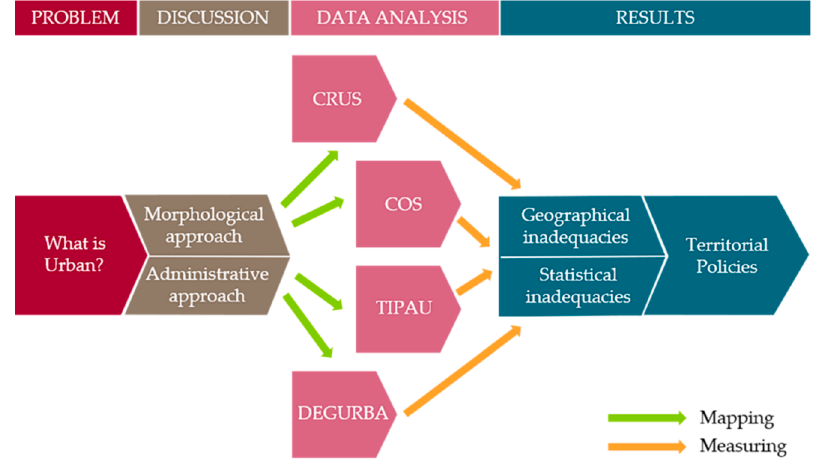
Figure 2. Methodological research stages (workflow design based on [47]).